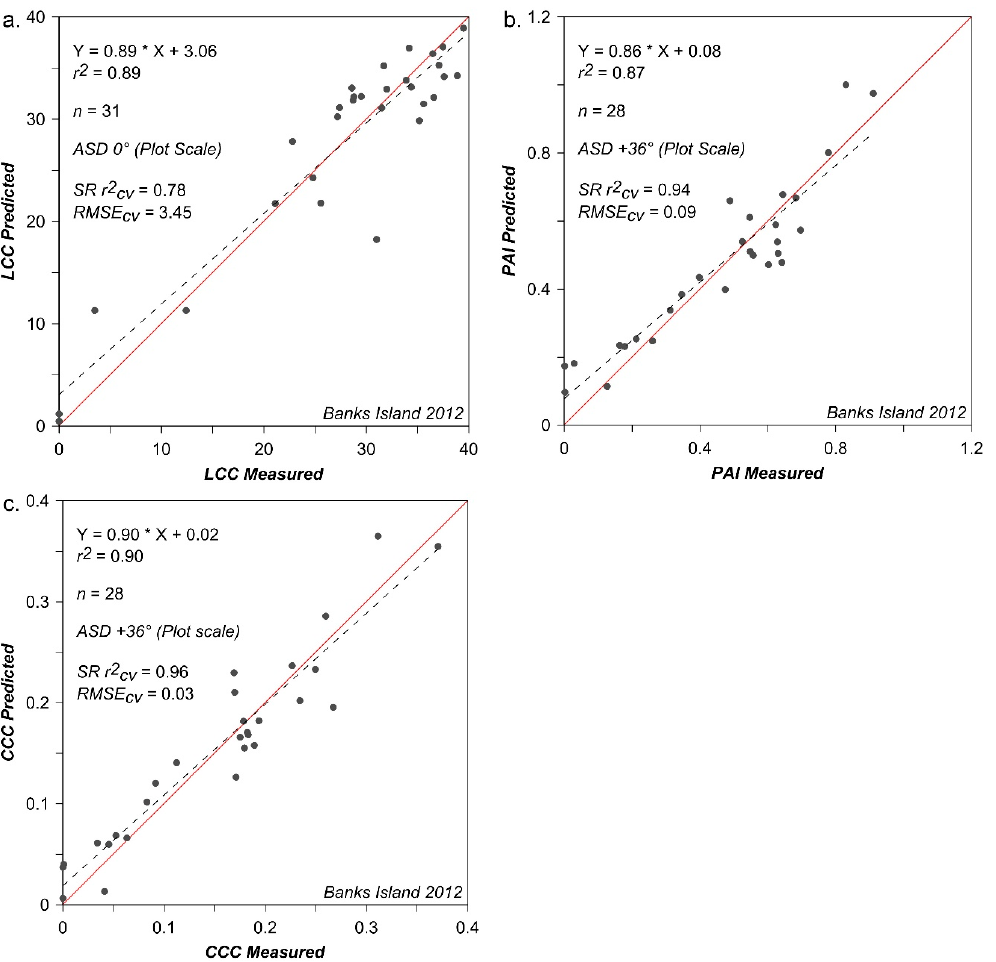
Figure 6. The best cross-validated SR model for each vegetation variable for Banks Island. ( a ) LCC, ( b ) PAI, ( c ) CCC. Banks Island produced the best overall model fits as compared to other field sites at lower